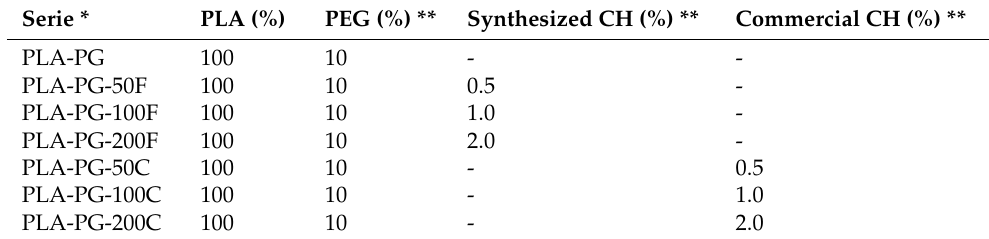
Table 1. Coding of the formulations of the elaborated